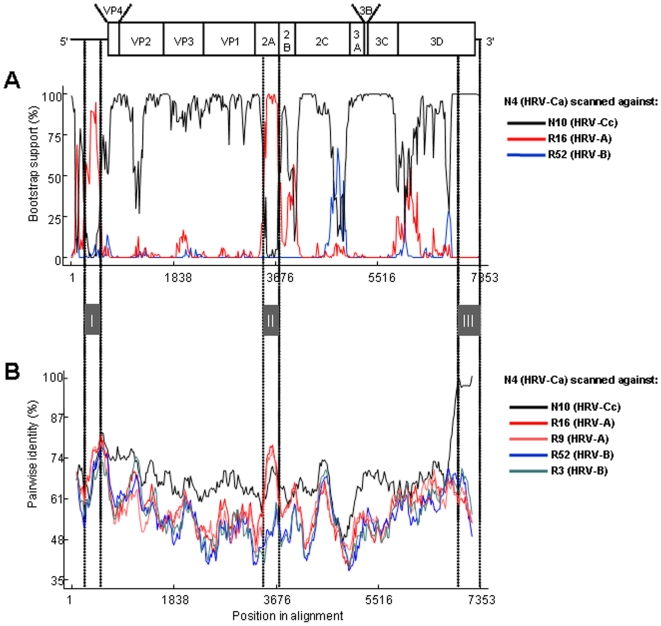
Analyses of recombination events in N4 isolate full-length genomic sequence.A: Result of manual bootscanning of N4 genome against several viruses. B: Pairwise identity of N4 with several viruses. Grey boxes indicate possible recombination sites.